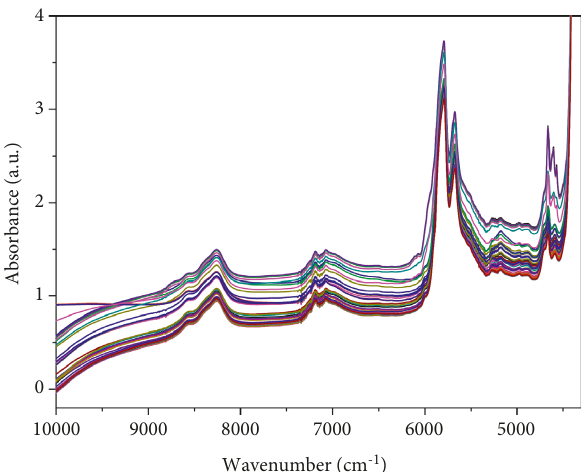
Figure 2: Near-infrared spectra of the 64 peanut oil samples.